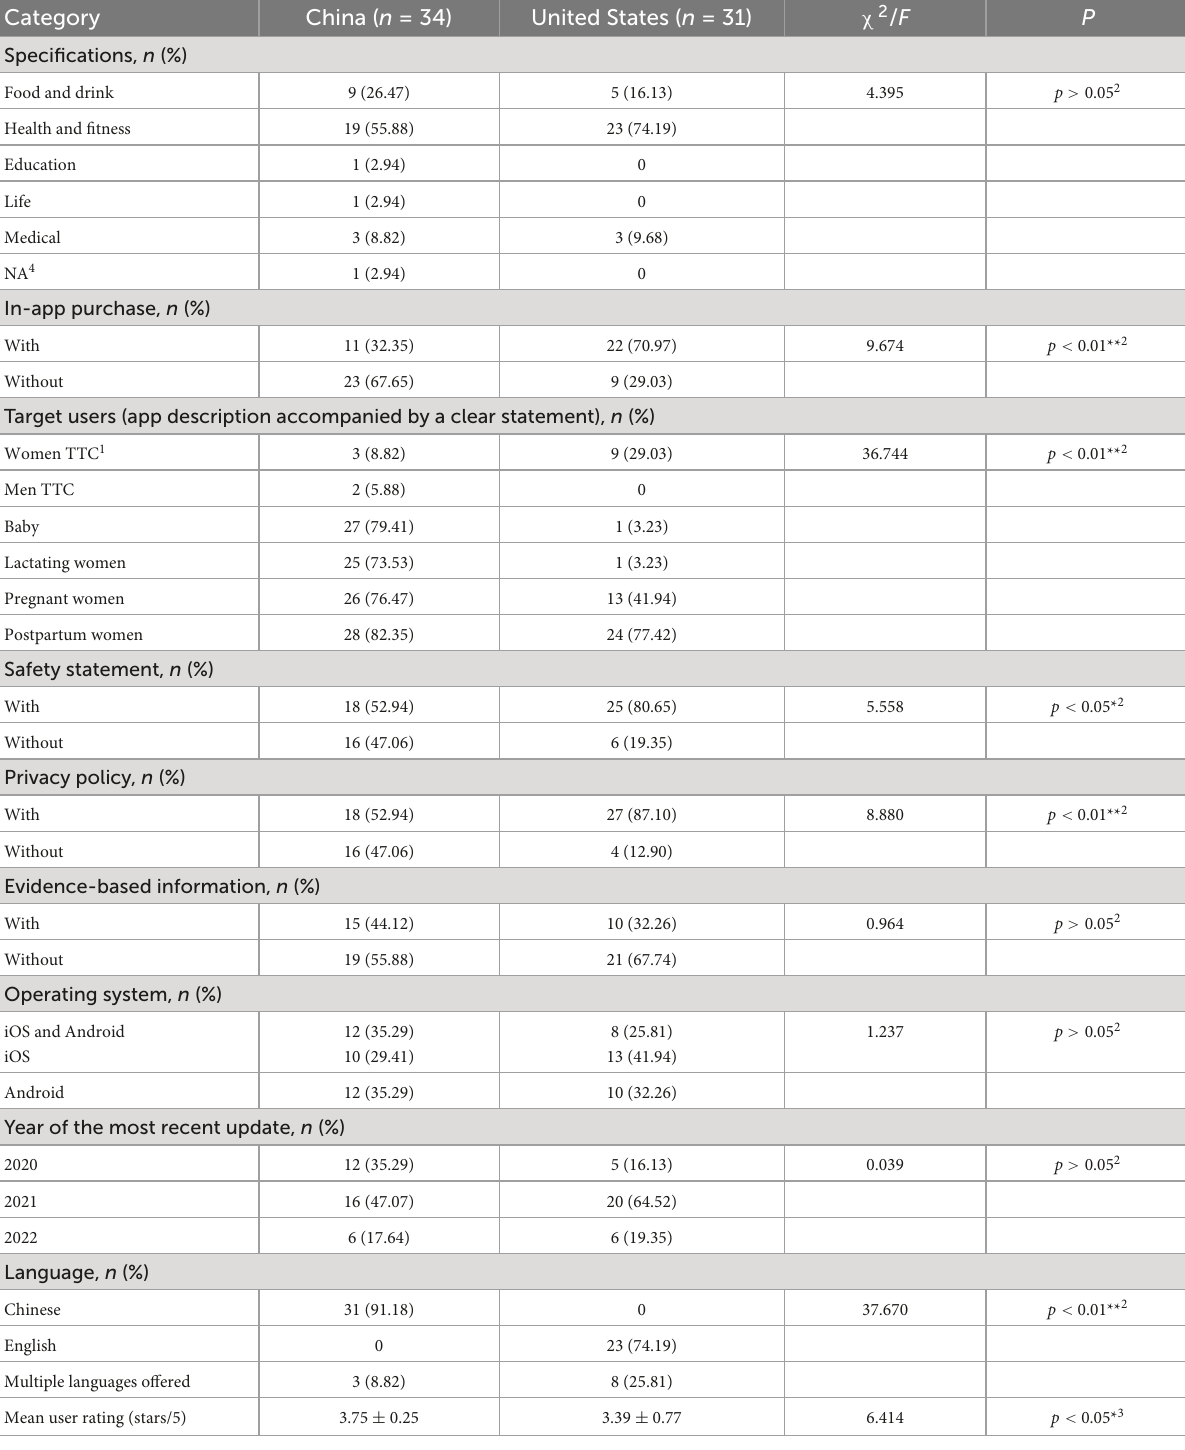
TABLE 1 Characteristics of the 65 nutrition and physical activity apps for prenatal through postpartum evaluated in a United States–China comparison. Category China ( n =